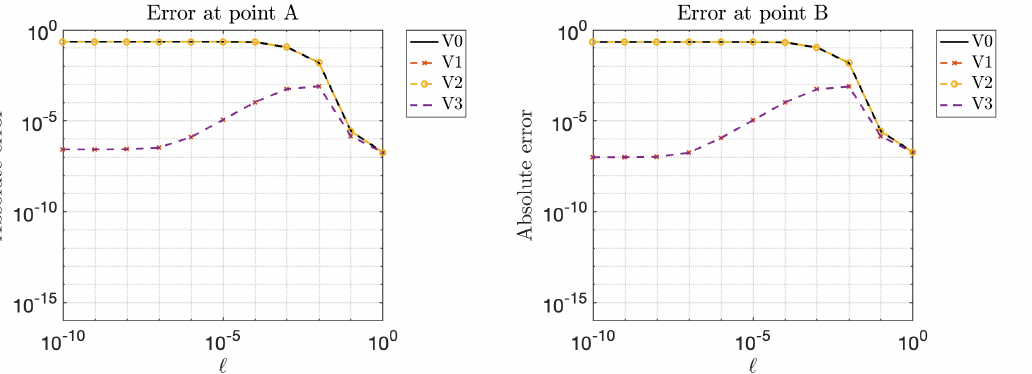
Figure 14. Helmholtz 3D. Log-Log plot of the error for the problem described in Figure 9 using N = 32, and for the four representations (standard or modified, off and on